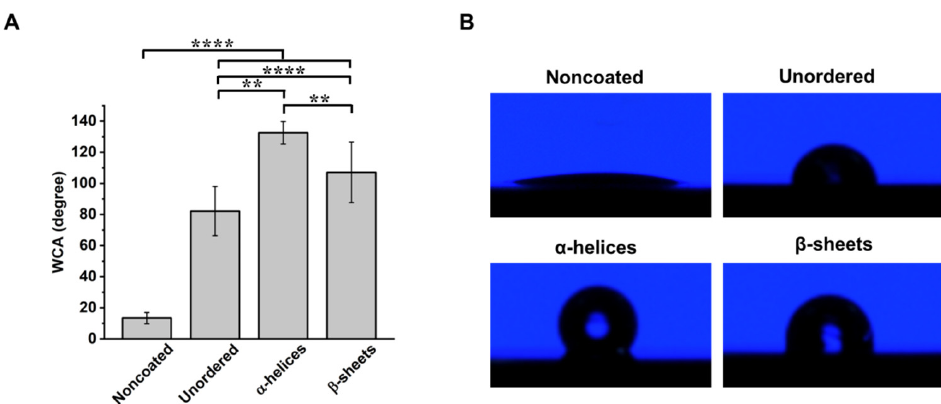
Figure 4. ( A ) WCA of noncoated Ti or Ti coated with GL13K as unordered peptides, self-assembled α -helices, or self-assembled β -sheets. N = 8 for each group. ** p -value < 0.01, **** p -value < 0.0001. ( B ) Representative images of sessile drops on different surfaces.